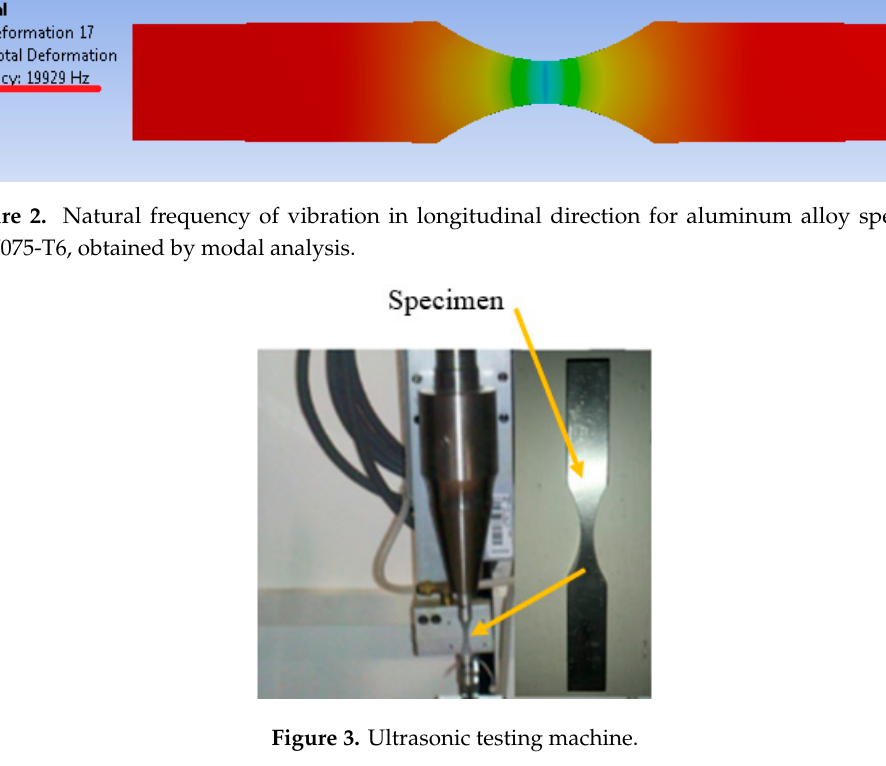
Figure 3. Ultrasonic testing machine.